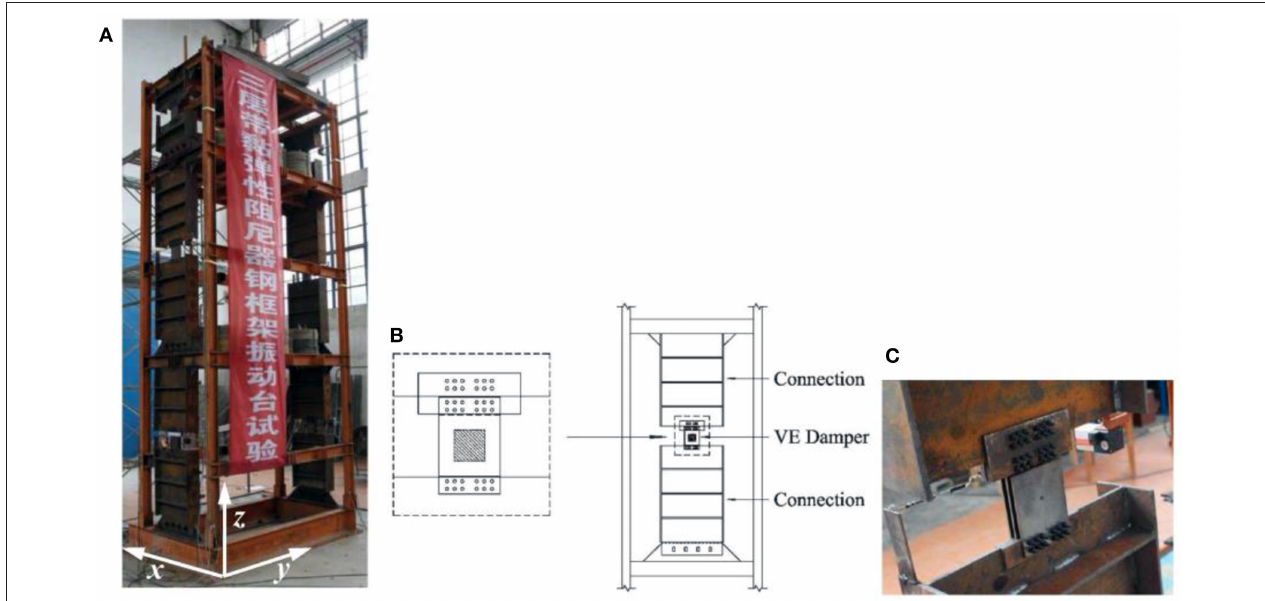
FIGURE 9 | Test structure with VE damping device, (A) overall model on the table, (B) connection detail of the VE dampers, and (C) picture of an installed VE damper.